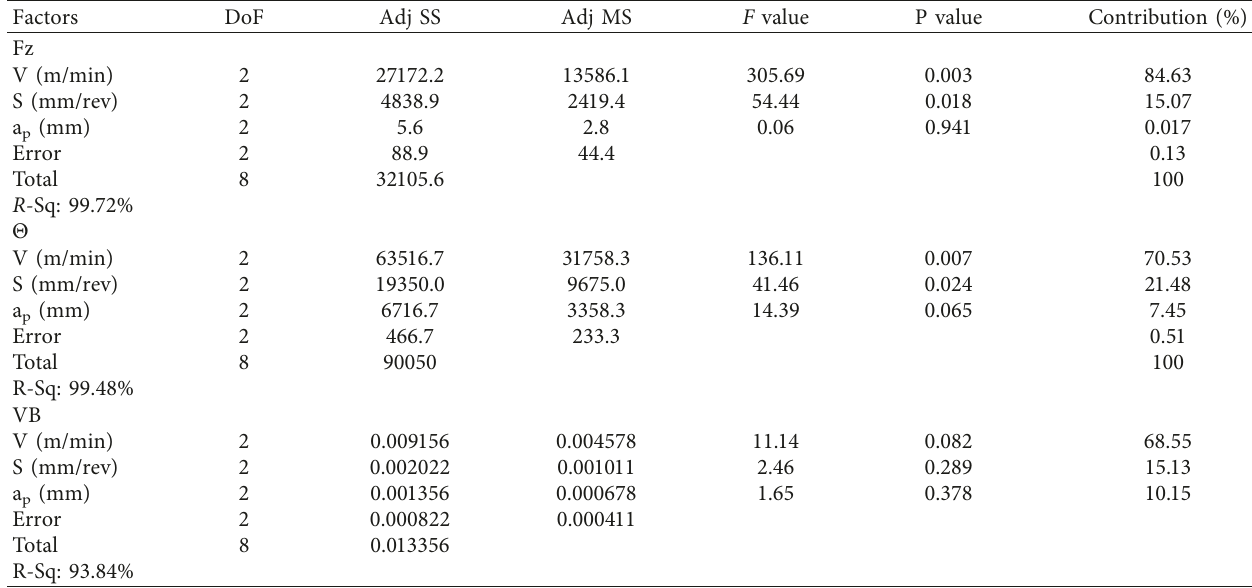
Table 8: ANOVA: results for Fz, Θ , and VB.